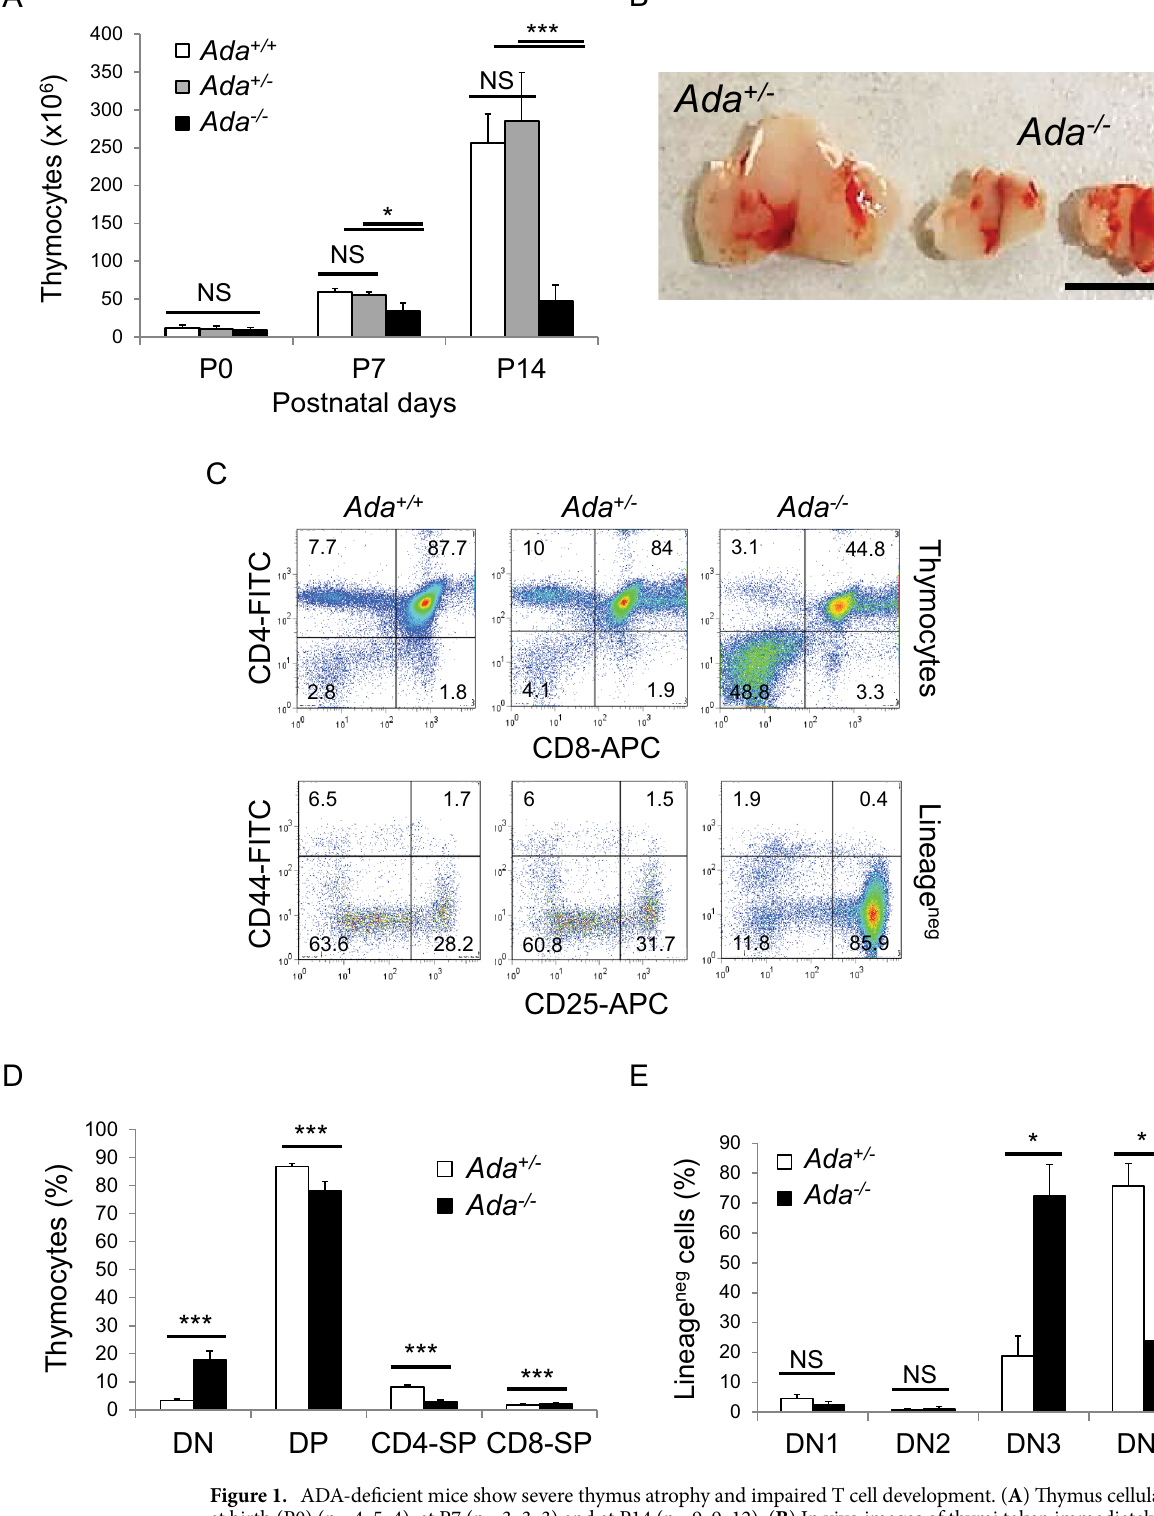
Figure 1. ADA-deficient mice show severe thymus atrophy and impaired T cell development. ( A ) Thymus cellularity at birth (P0) (n = 4, 5, 4), at P7 (n = 3, 3, 3) and at P14 (n = 9, 9, 12). ( B ) In vivo images of thymi taken immediately after dissection at P14. ( C ) FACS plots of thymocytes from P14 thymi showing (upper panel) cell distribution among DN (CD4 − , CD8 − ), DP (CD4 + , CD8 + ), CD4-SP (CD4 + , CD8 − ) and CD8-SP (CD4 − , CD8 + ) populations and (lower panel) cell distribution among DN1 (CD44 + , CD25 − ), DN2 (CD44 + , CD25 + ), DN3 (CD44 − , CD25 + ) and DN4 (CD44 − , CD25 − ) Lin neg populations. ( D and E ) Bar graphs representing percentages of cell population shown in (C) (n = 6, 4). DN = double negative, DP = double positive, SP = single positive. Quadrant numbers represent relative cell percentages. Statistical analysis was performed using the two-tailed homoscedastic Student’s t-Test. Data represent means ± SD. P values < 0.05 were considered significant. * P < 0.05, ** P < 0.01 and *** P < 0.001. NS = statistically not